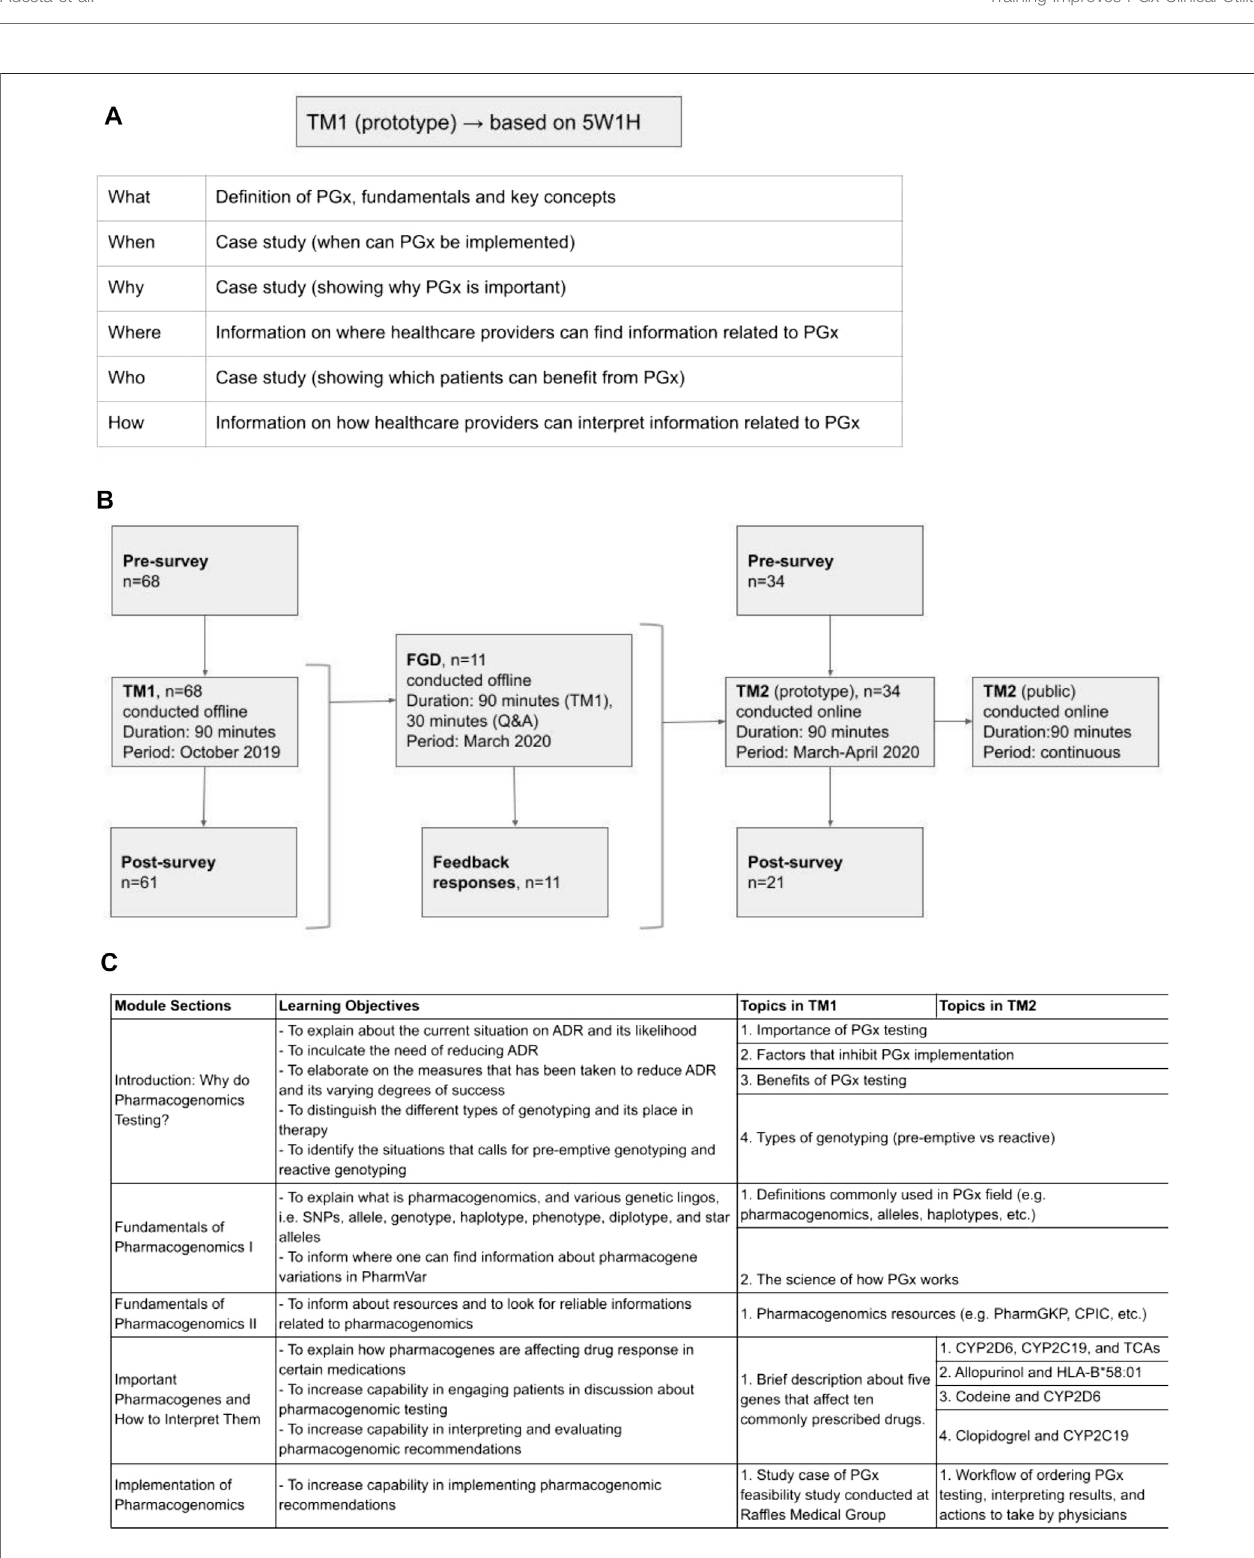
FIGURE 1| Development oftraining materials. (A) Questions composed of5W1H (what, when, why, where, who, and how) are used to determine the fi rst training materials and objectives. (B) The fi rst training material (TM1) was designed based 5W1H questions as seen on Panel 1A and implemented in an of fl ine training. Focus group discussion (FGD) with the TM1 ’ s training participants was held of fl ine to collect feedback. Feedback from the FGD was used to develop more comprehensive training materials (TM2) and implemented as online training. (C) Details of the learning objectives and topics covered in TM1 and TM2.